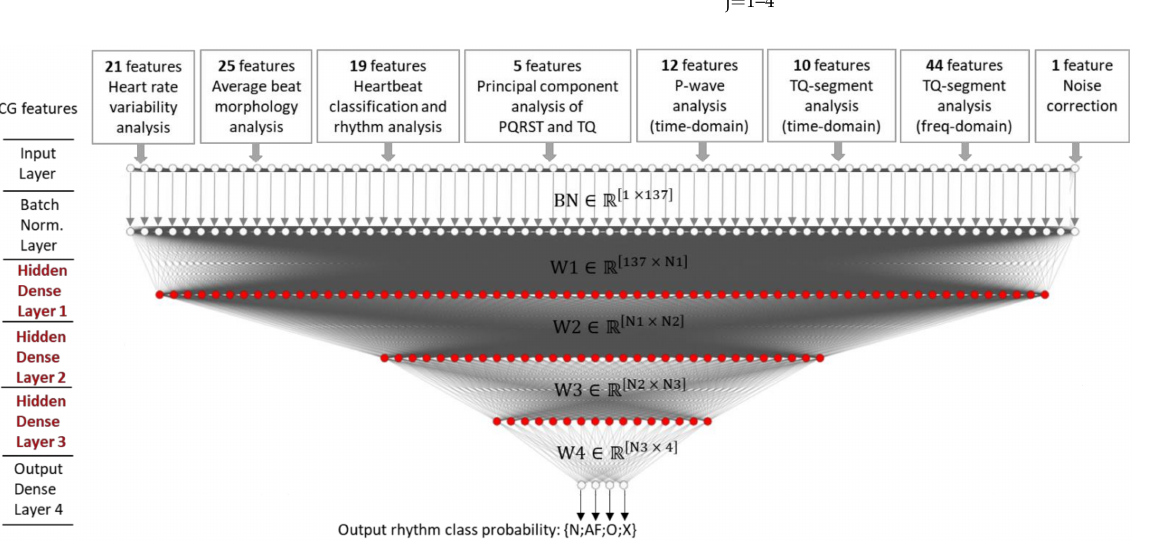
Figure 1. General DenseNet architecture optimized for rhythm classification {N,AF,O,X} with 137 input ECG features, batch nor- malization layer and configurable dense layers (depth, size): {number dense layers} = [1–4], number nodes@N{1–3} = [0–1024] (red dots). W{1–4} stand for all trainable dense layer weight